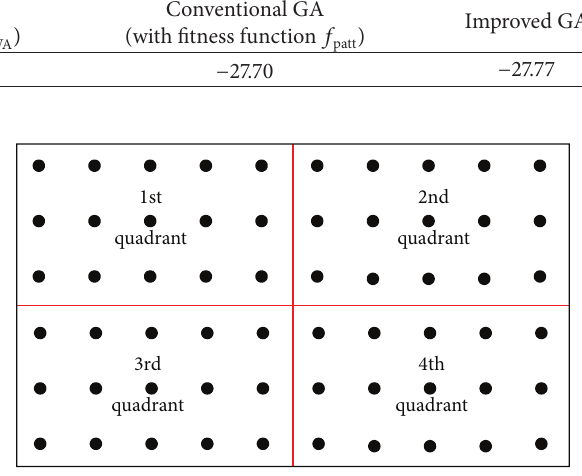
Figure 9: The division of planar array into four